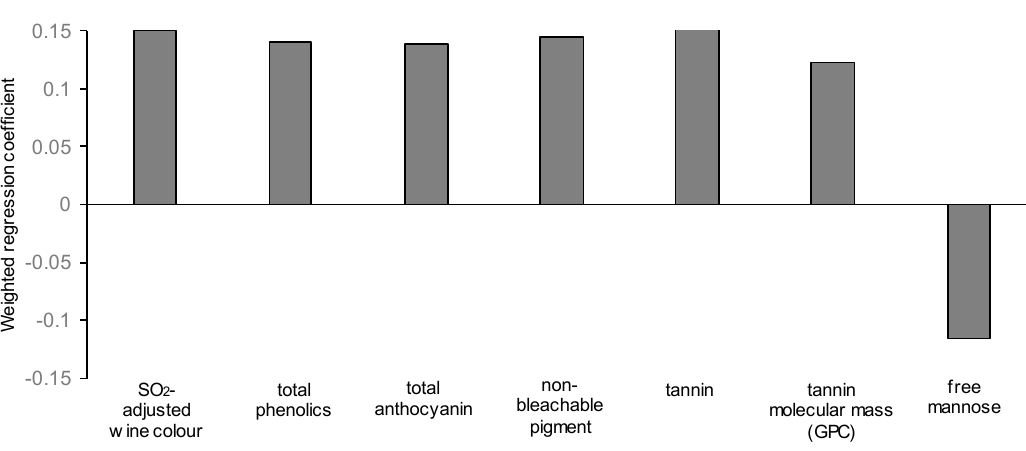
Figure 3. Weighted regression coefficients determined from partial least squares regression (PLS1) analysis of significant wine compositional variables to predict the sensory attribute opacity.